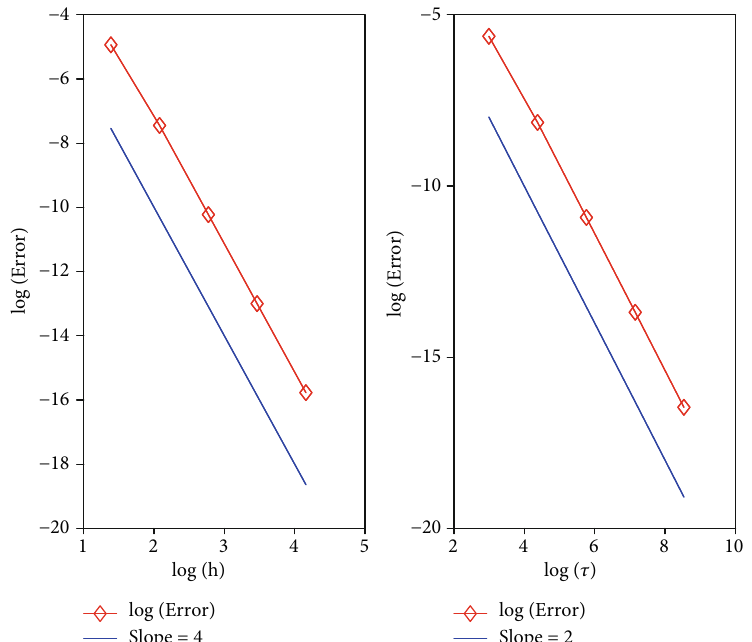
Figure 1: Order of spatial and temporal convergence.